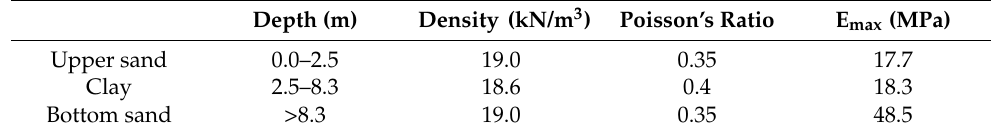
Table 1. Basic soil properties at the site.